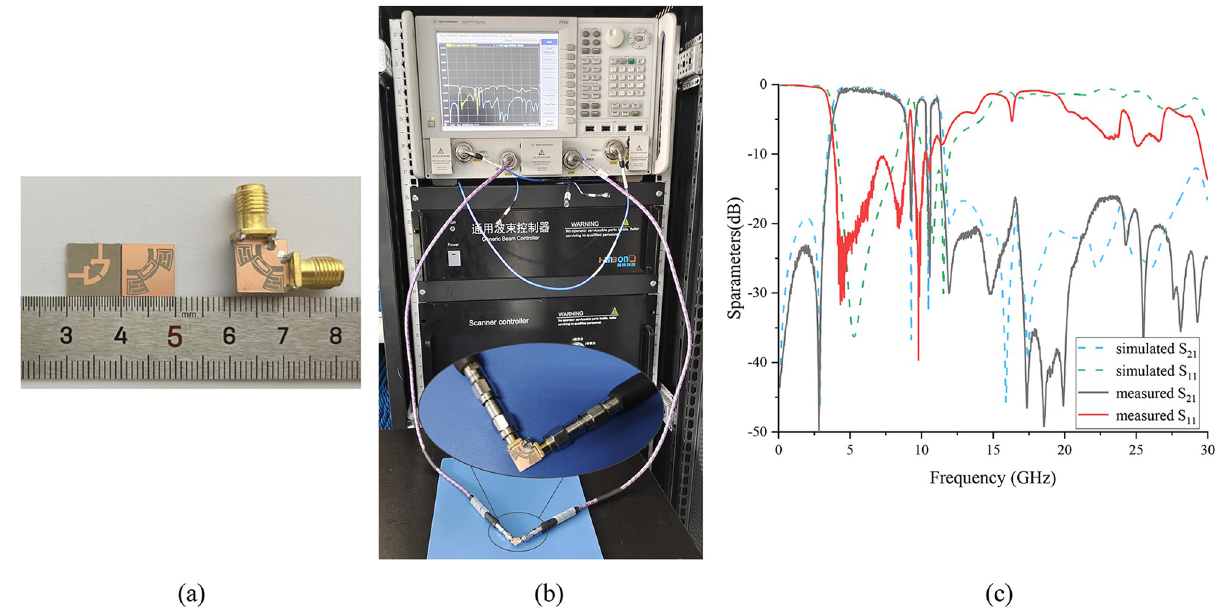
Fig 17. (a) the top and ground views of the fabricated prototype. (b) measurements are made using a vector network analyzer. (c) comparison of measured results and simulation results.